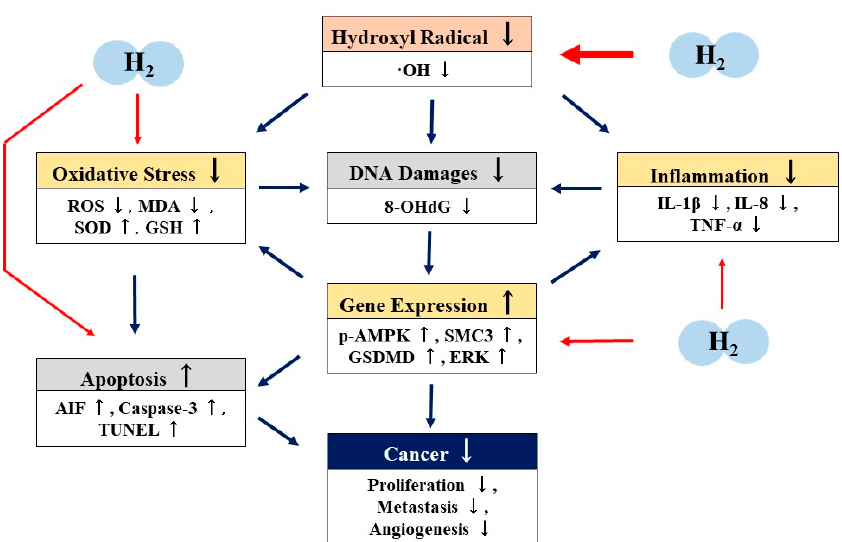
Figure 2. Possible mechanism of the antitumor effects of molecular hydrogen (H 2 .) H 2 scavenges hydroxyl radicals (·OH) directly. H 2 also exhibits antioxidant, anti-inflammatory, and apoptotic effects through the regulation of gene expression indirectly. Through these direct and indirect actions,